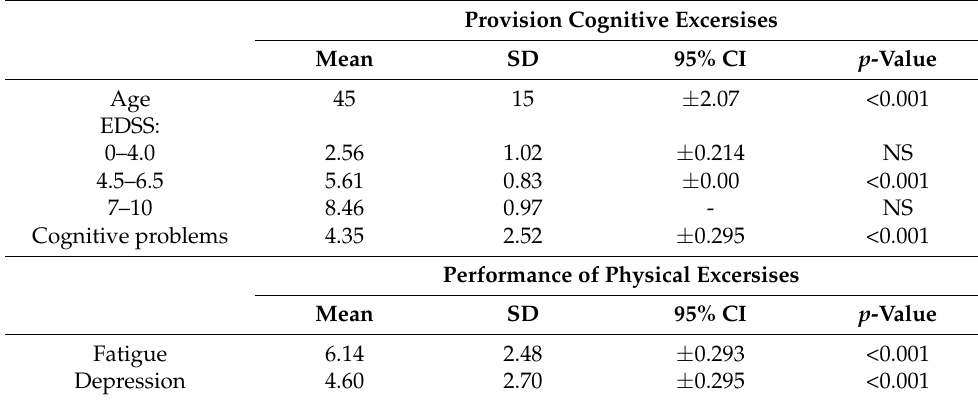
Table 5. Correlates of demographics, disease-specific variables, and priority level of the